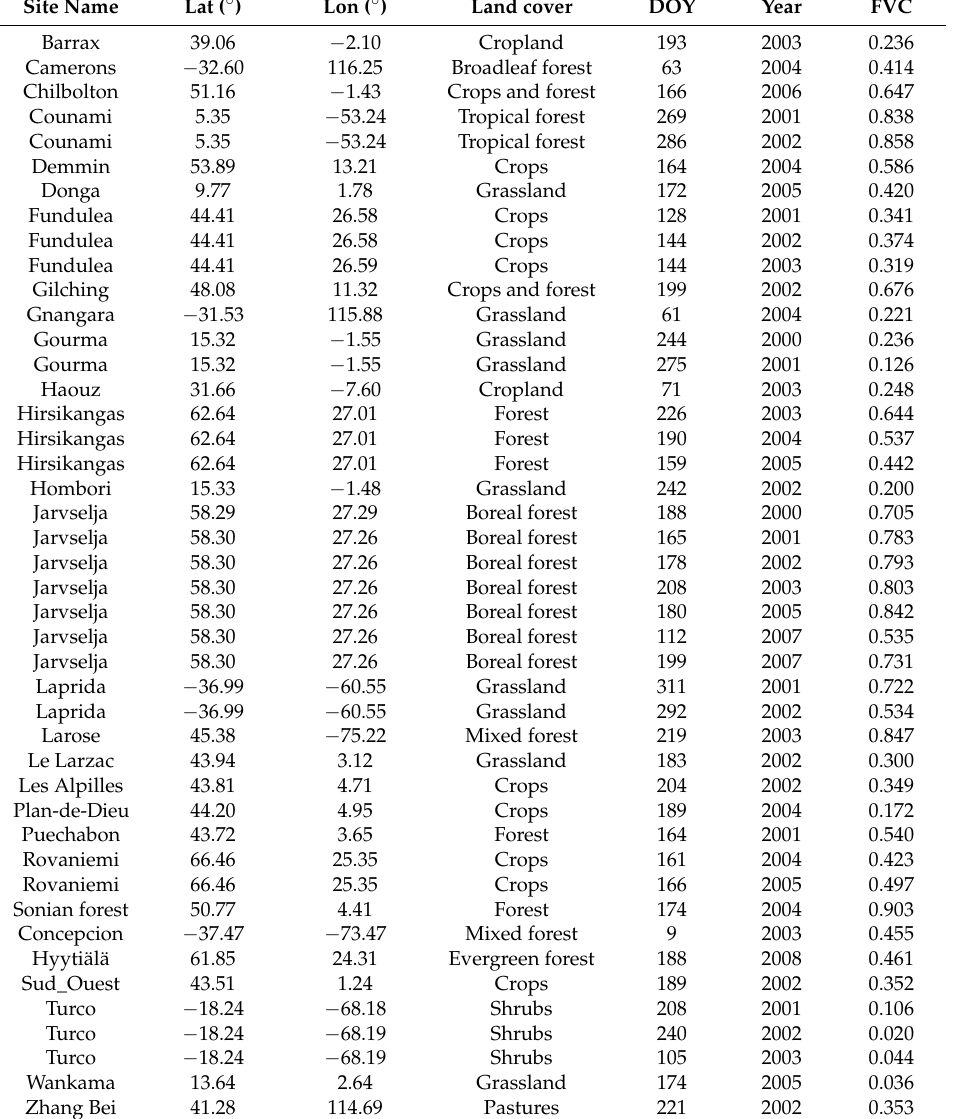
Table 1. Characteristics of the sites selected for accuracy